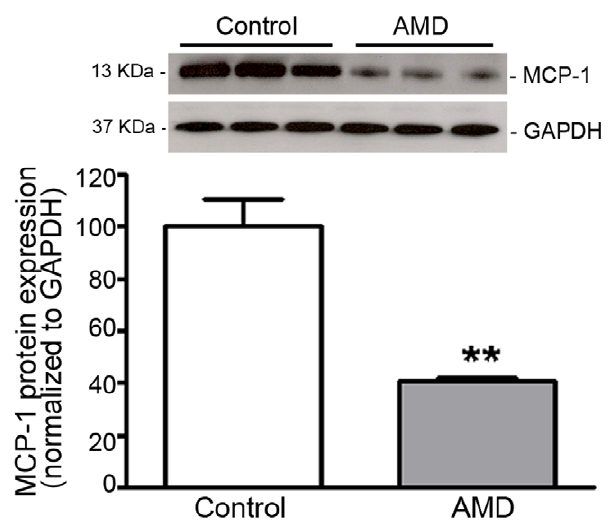
Figure 1. MCP-1 expression is decreased in RPE from smoker AMD patients. MCP-1 protein expression was evaluated by Western blot in RPE lysates from 3 smoker donors with AMD and 3 age-matched non smoker controls with no known history of eye disease. GAPDH served as loading control. Top: representative Western blots of the indicated proteins. The numbers to the left are molecular weights in kilodaltons (KDa). Bottom : average densitometry results. Data are expressed as percentage of control and are means 6 SE. **p , 0.01 versus control.